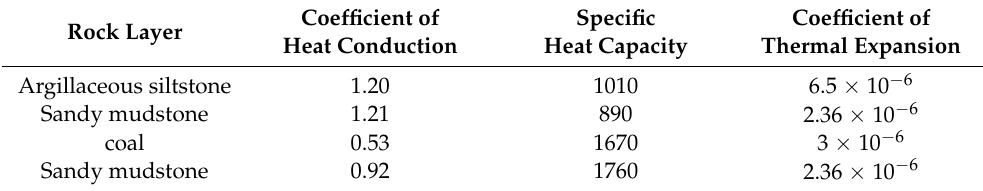
Table 2. Initial thermal parameters of the stratum in the experimental